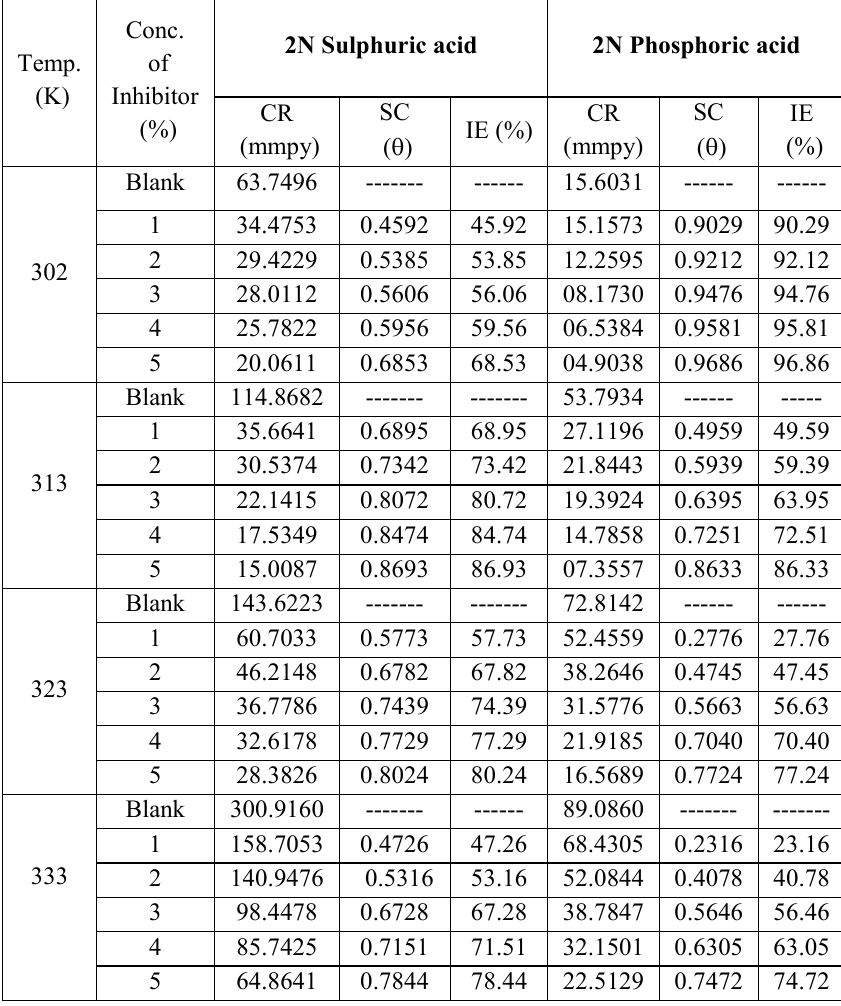
Table 1 Corrosion parameters of Morpholine on mild steel in 2N sulphuric acid and 2N phosphoric acid by weight loss